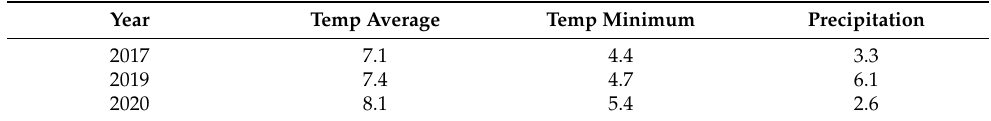
Table 9. Temperature (in °C) and precipitation (in mm) data for the month of April (end of ablation time) in the years 2017, 2019 and 2020 on the Tyndall Glacier (Temp-Temperature).